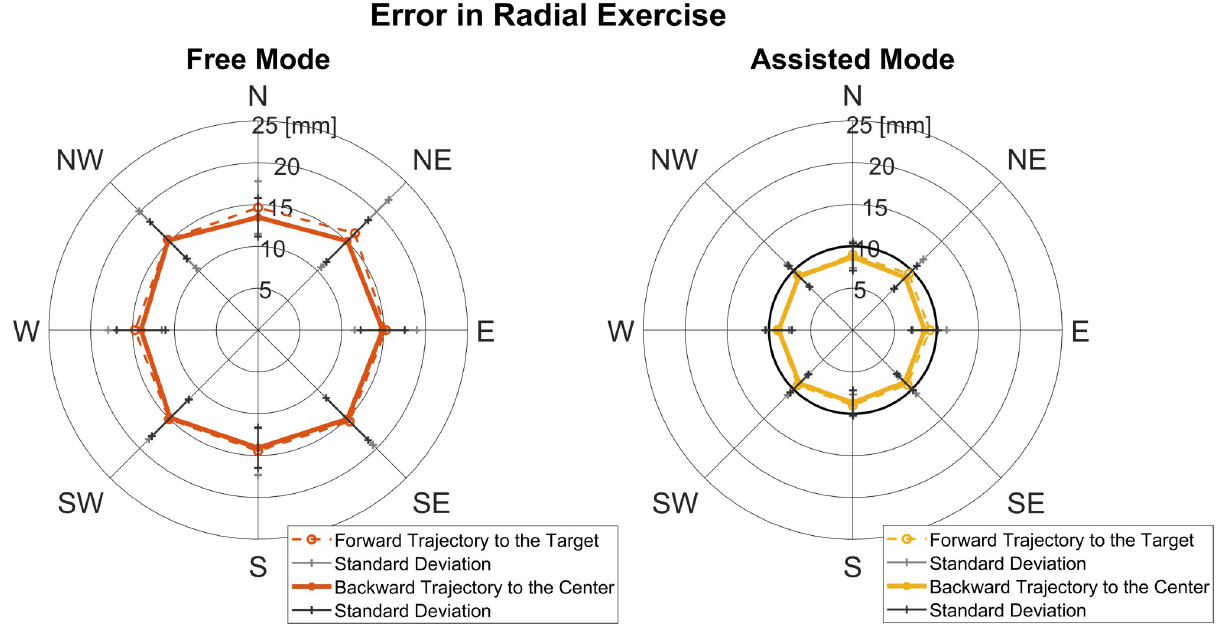
Fig 6. Radial kinematic error. Mean inter-subject error and deviation in the Radial mode displayed for trajectories towards the targets and back to the center. For the Assisted mode, we also displayed the radius of the assistance tunnel in black.